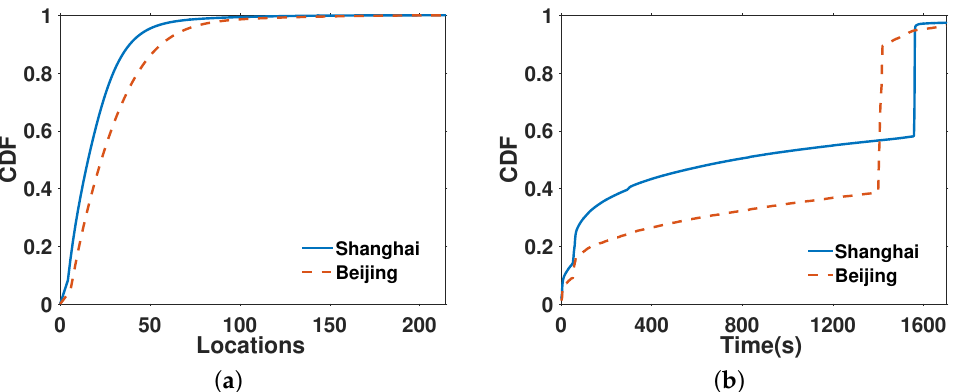
Figure 6. Spatio-temporal features of two mobility datasets, with Cumulative Distribution Function of ( a ) different locations that users visit and ( b ) time intervals between consecutive records.